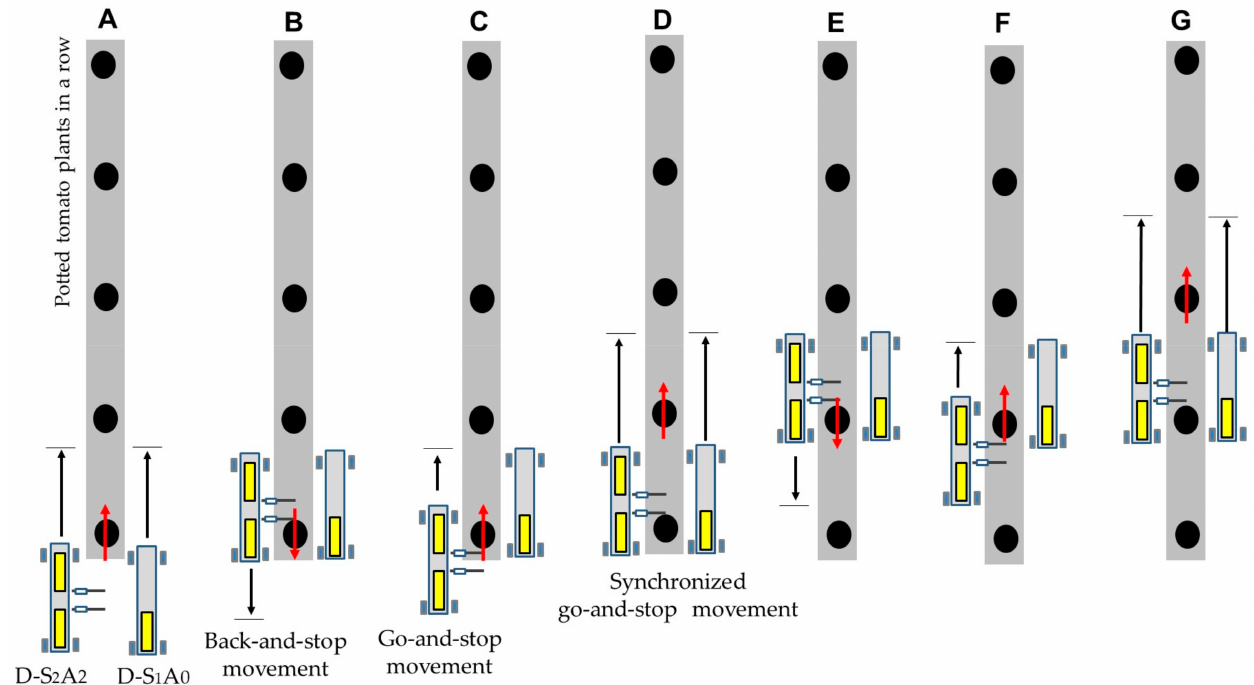
Figure 3. Step-by-step synchronous movements of two dollies (D-S 2 A 2 and D-S 1 A 0 ) from plant to plant. Five potted tomato plants were arrayed in a row and 20 whiteflies were transferred to the leaves of each plant. The D-S 2 A 2 was placed on one side of the plant and the D-S 1 A 0 on the other. Both dollies were manually remote-controlled. The D-S 2 A 2 moved forward and backward along one plant and then moved to the next plant; the D-S 1 A 0 moved forward in step with the forward movement of the D-S 2 A 2 . Each plant was tapped six times by the two arms of the D-S 2 A 2 (via the go-back-go movement). All plants were treated in the same manner. Black and red arrows represent the direction of dolly movement and plant tapping by the arms, respectively. The whiteflies captured by three YDD-EFSs were counted after the final tapping of the fifth plant. The second approach was similar but proceeded in the opposite direction; it trapped whiteflies that remained on the